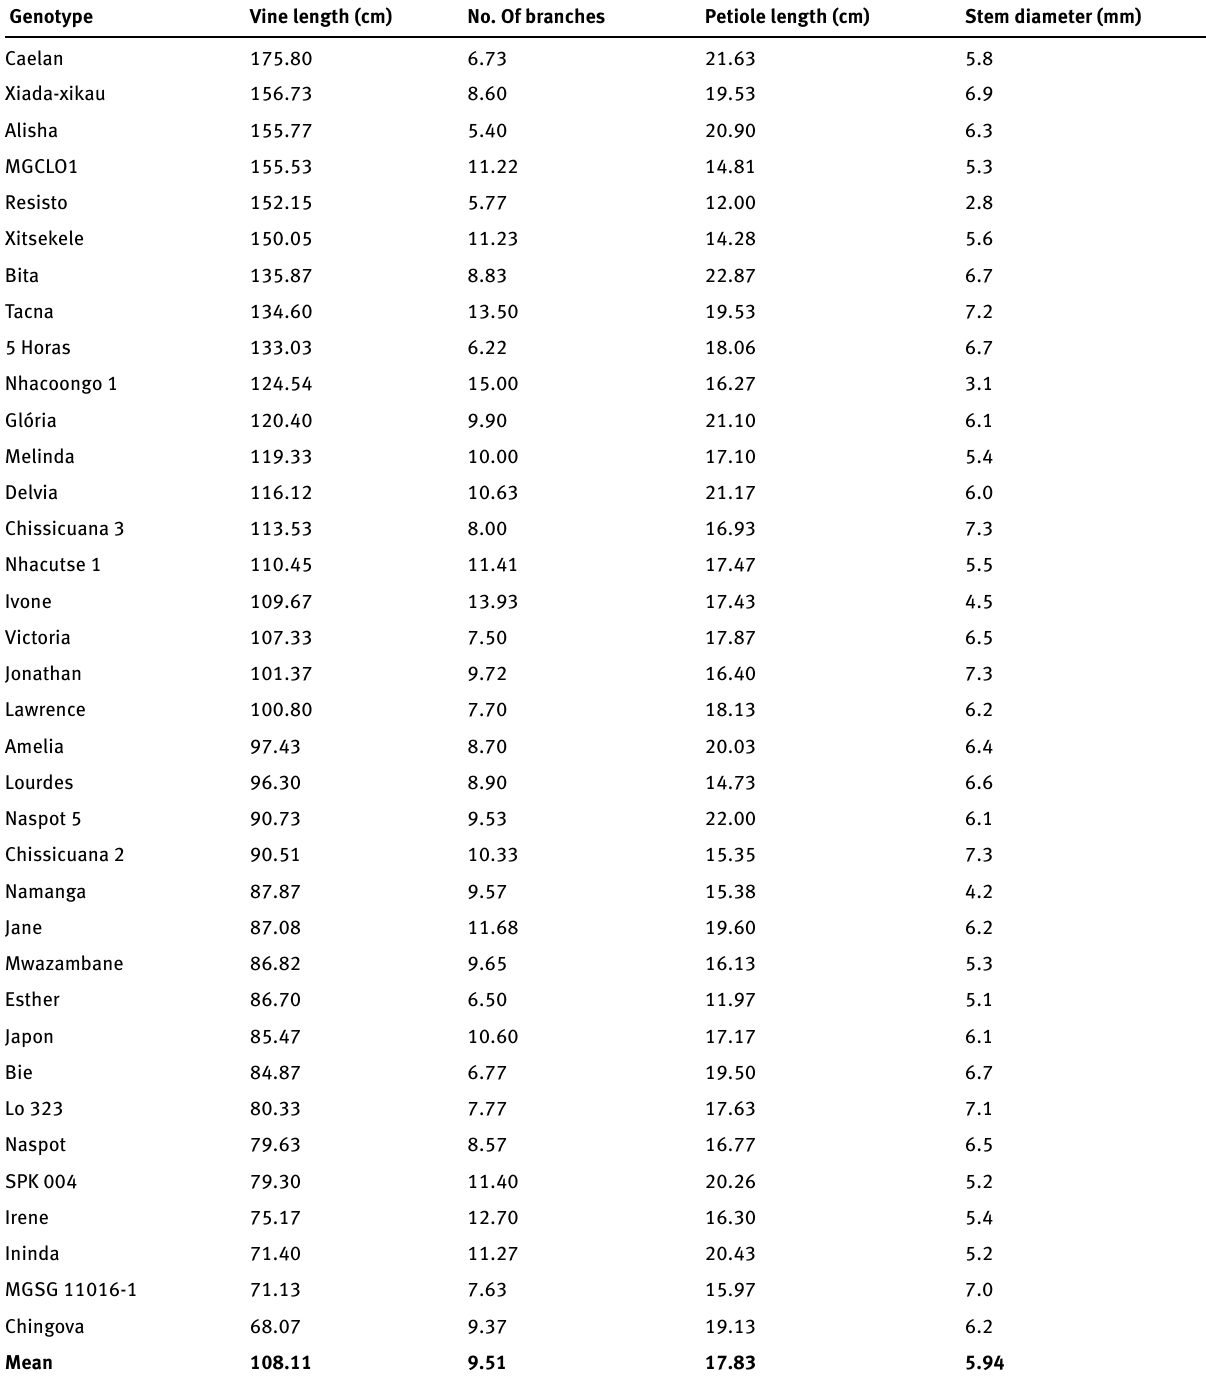
Table 2: Genotypic means for vine length (cm), number of branches per plant, petiole length (cm) and stem diameter (mm) measured at